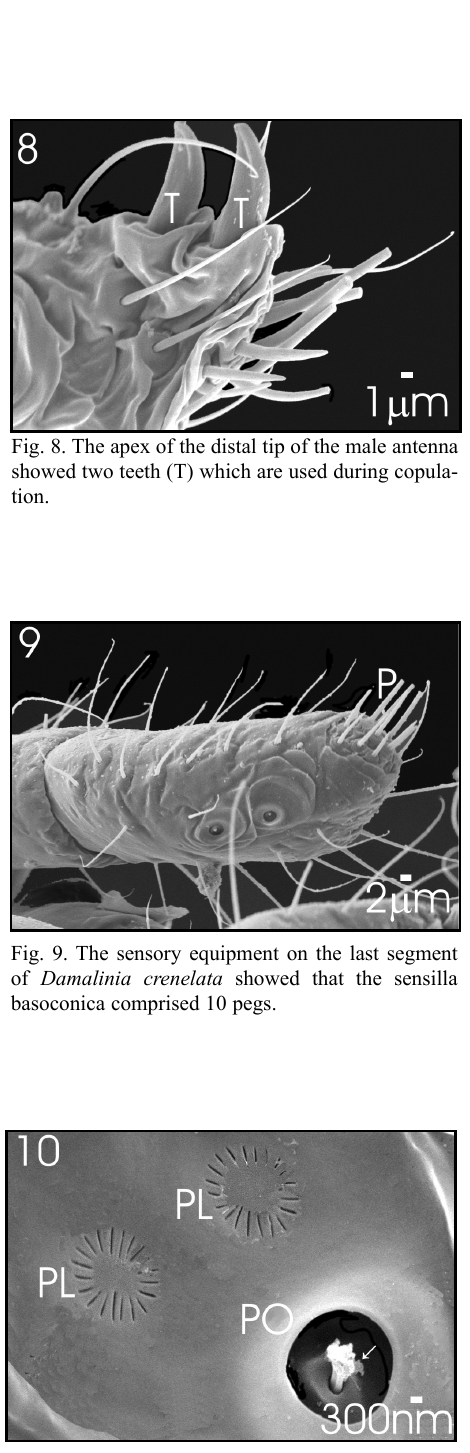
Fig. 10. Apore organ (PO) with adjacent plate organs (PL) which were found on the last antennal segment. (Arrow = tuft or pit